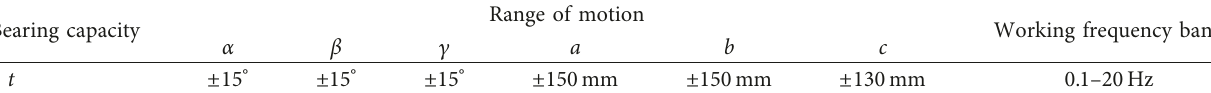
w b w b w b x y z (cid:31)